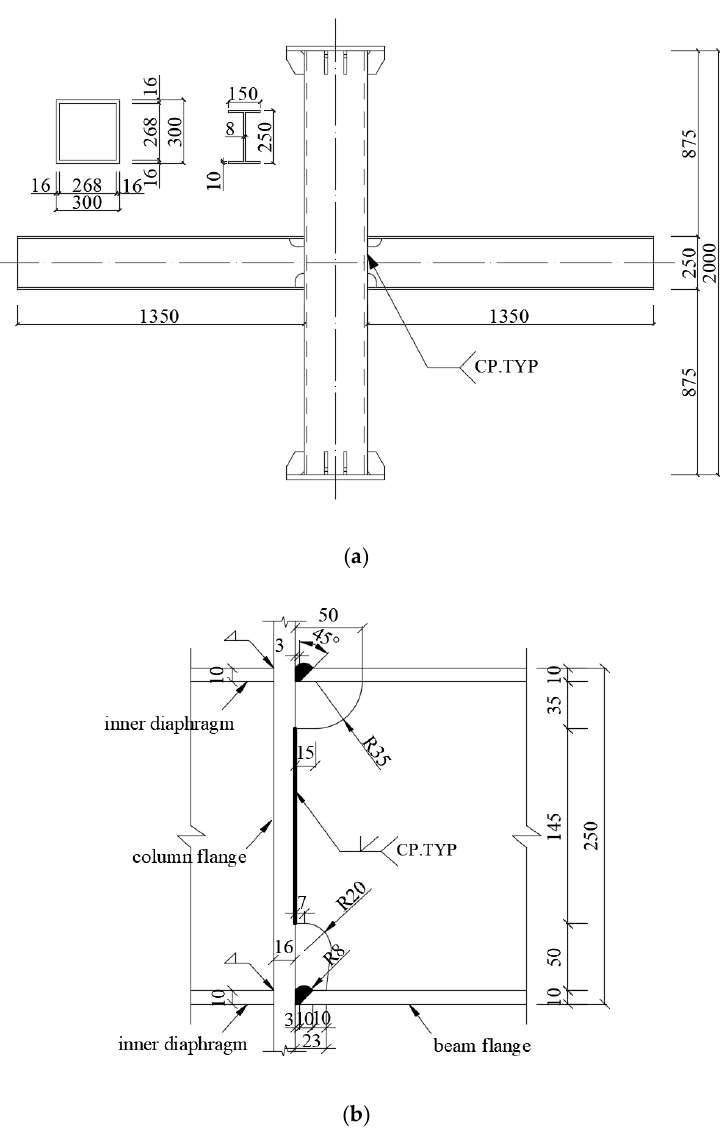
Figure 4. Design of specimen (mm): ( a ) beam-to-column welded joint; ( b ) welded structural details.